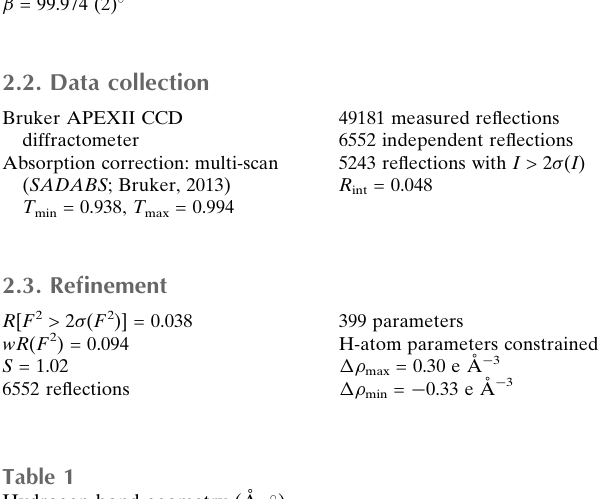
Hydrogen-bond geometry (A˚ , (cid:2) ). Cg 1 is the centroid of the C18–C23